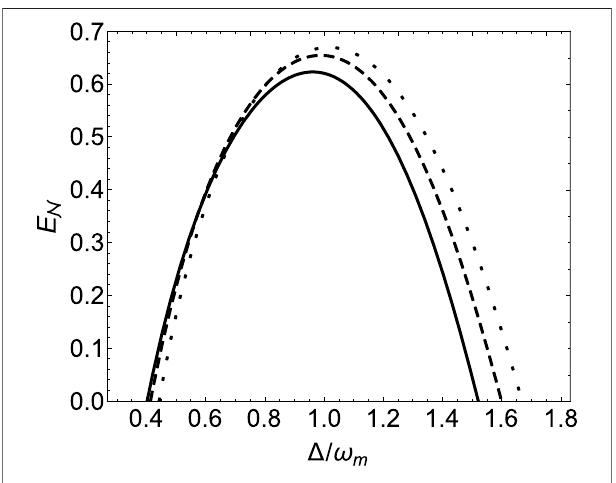
FIGURE3| Plot oflogarithmic negativity E N asafunctionoftemperature T of the system temperature. Normalization detuning Δ / ω m (cid:1) 1 . 0, and the otherparametershavethesamevaluesasthosein Figure2 .Thethreecurves correspond to different frequencies: for different cavity frequencies ω c . The solid line refers to ω c (cid:1) 3 ω 0 , the frequency corresponding to the dash line is 3 . 5 ω 0 , and for the dotted line, ω c (cid:1) 4 ω 0 .